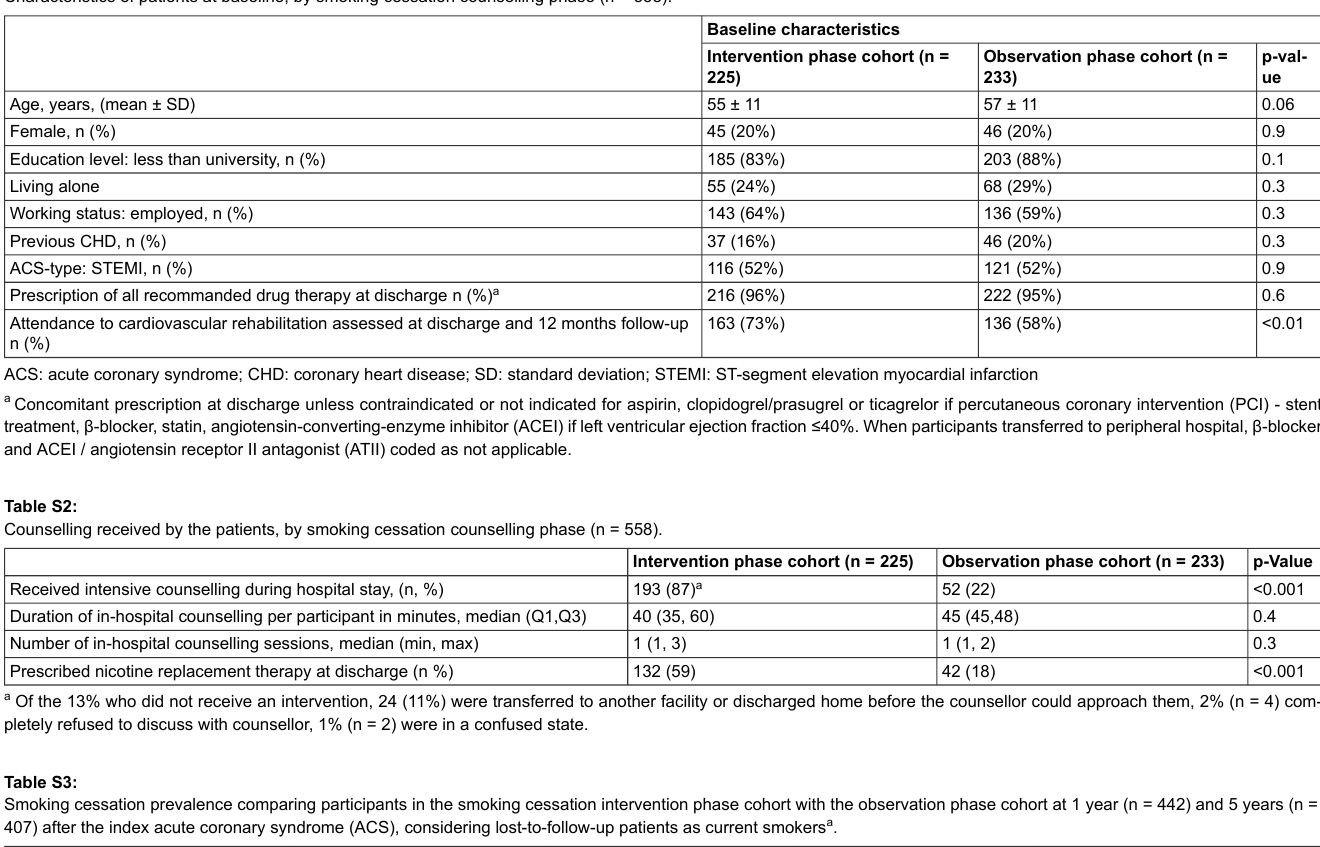
Table S1: Characteristics of patients at baseline, by smoking cessation counselling phase (n = 558).